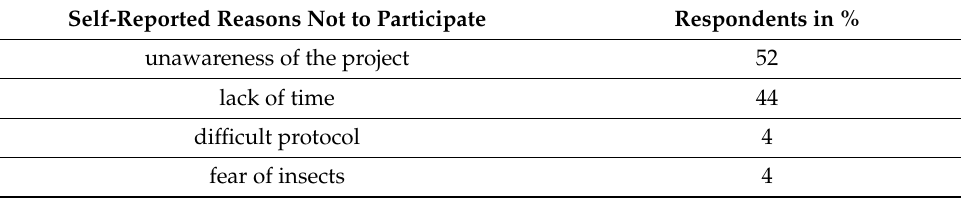
Table 5. Self-reported reasons not to participate in the pollinator CS project, multiple answers possible, N =